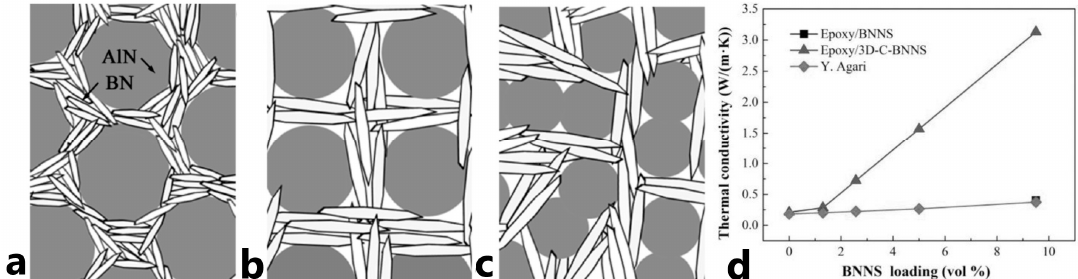
Figure 12. Schematic image of the BN@AlN systems in relation to ( a ) 2:1, ( b ) 1:1 ( c ) 1:2 (Reprinted with permission from Elsevier, copyright 2012) [104], and ( d ) thermal conductivity of composite based on BN nanosheet at room temperature (Reprinted with permission from John Wiley and Sons, copyright 2016) [87].